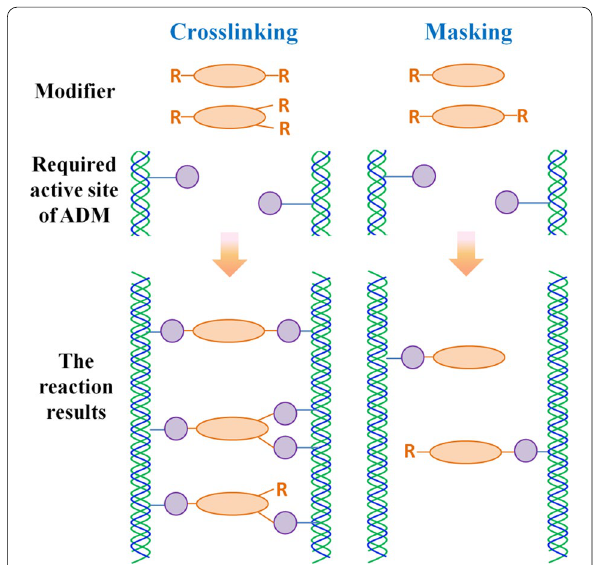
Fig. 2 Schematic drawing of crosslinking and